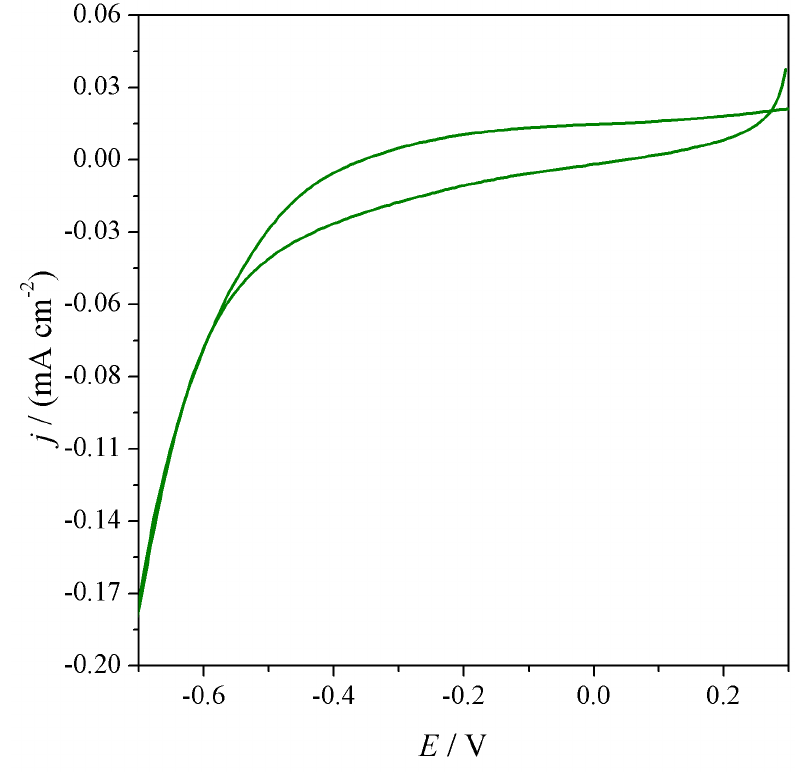
Table A1. Drying temperature, pressure, and time of PEDOTs’, PEDOT_Naphs’, and PEDOT_SPAESs’ polymeric solutions in DMF, and the stabilization time and current of the corresponding modified electrode. Figure A11. Cyclic voltammogram of PEDOT dried from DMF in KCl 0.1